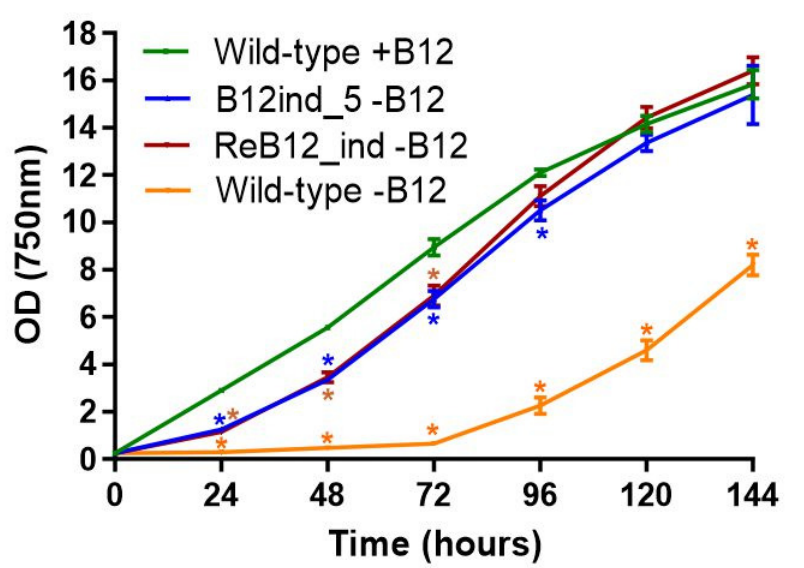
Figure 4. Growth of wild-type and B 12 -independent mutants in liquid AD7 medium. Wild-type was cultured in B 12 − and B 12+ medium. Strains were cultured at 38 ◦ C under 300 µ mol photons m − 2 s − 1 continuous light intensity and with direct bubbling of air/5% CO 2 . Error bars indicate SD. Asterisks indicate significant differences between wild-type +B12 and the other strains and wild-type − B12 ( p < 0.05).